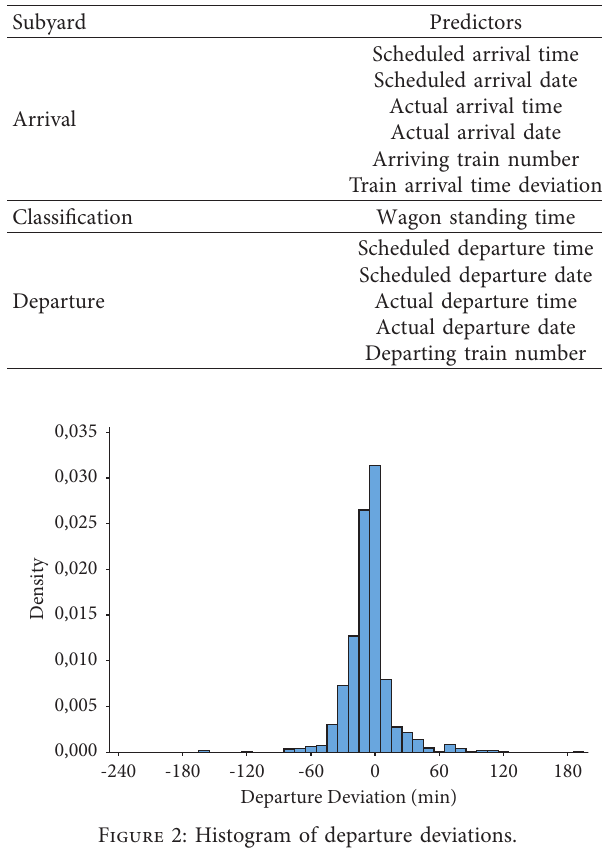
Figure 1: A conventional European shunting yard layout [28]. Table 1: The selected predictors.